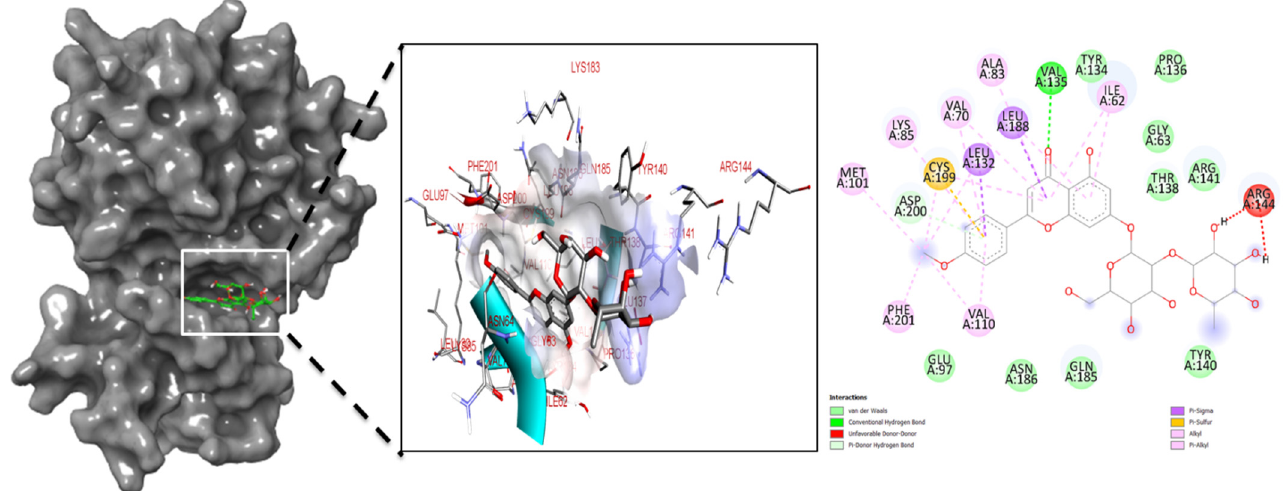
14 of 20 Table 3. Binding energy, predicted inhibitory concentration profile, and residue interactions between ligands and gly- cogen synthase kinase 3 β (PDB IDs: 1Q5K). Complex